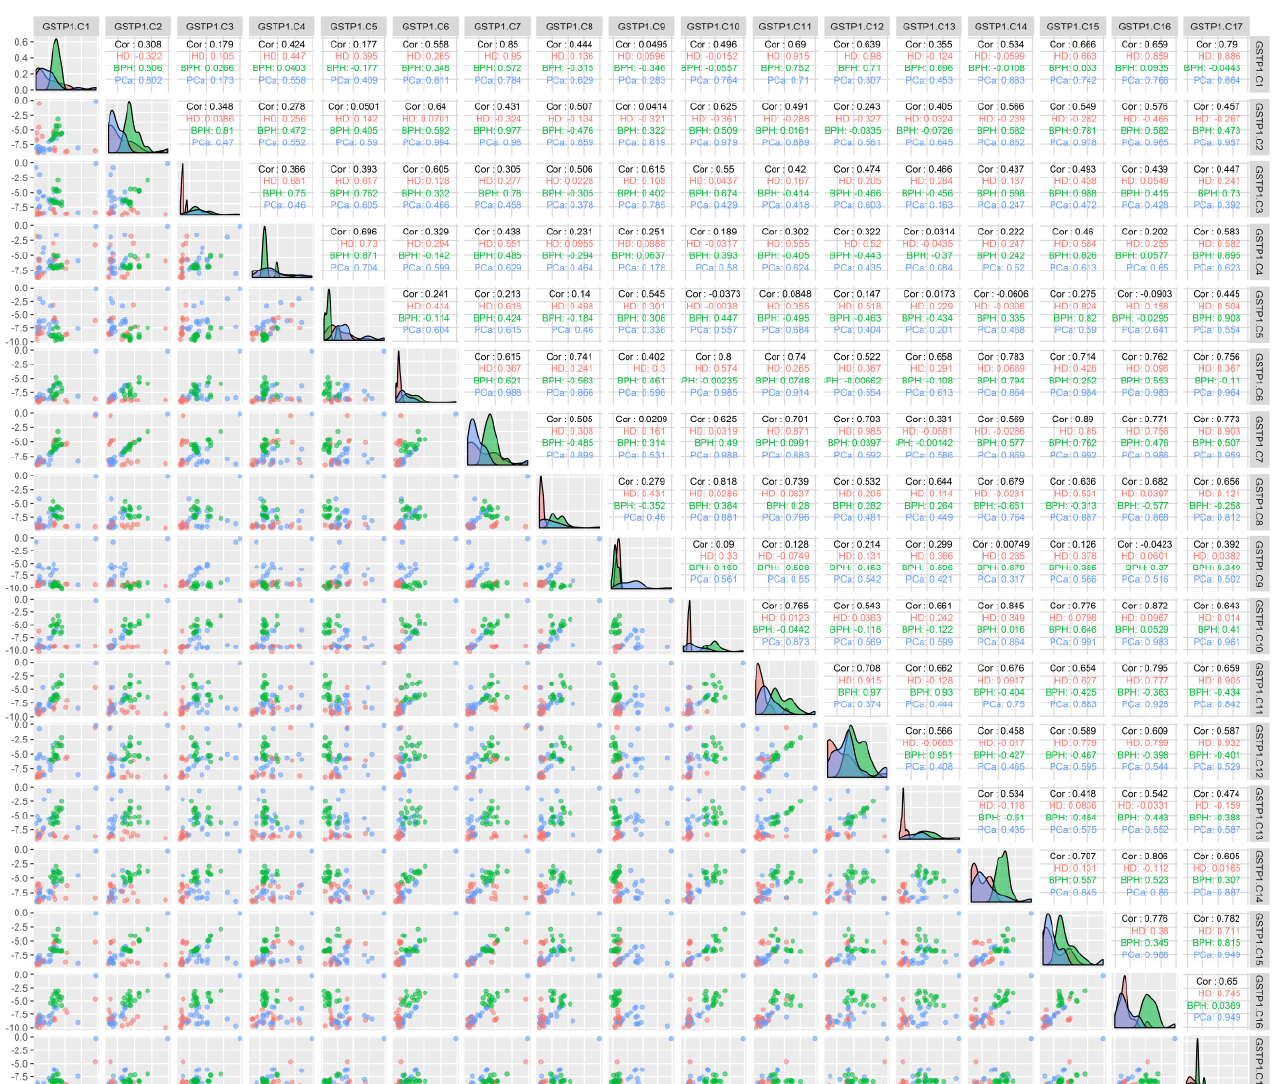
Figure 2. Correlation between the methylation of the individual cytosines of the studied locus of the GSTP1 gene and the composition of DNA in the circulating blood of the studied patients. The binary logarithms of the variables were used for all the plots. The diagonal cells present the density plots for the HD (red), BPH (green), and PCa (blue) groups for each of the variables. Each diagonal cell has its own y -axis scale, which is not labeled. “HD”, “BPH”, and “PCa” denote the respective Pearson correlations for each of the groups. “Cor” denotes the Pearson correlation for all the groups combined; the correlations were calculated for the binary logarithms of the variables. The cells below the diagonal present the scatterplots for each pair of variables.